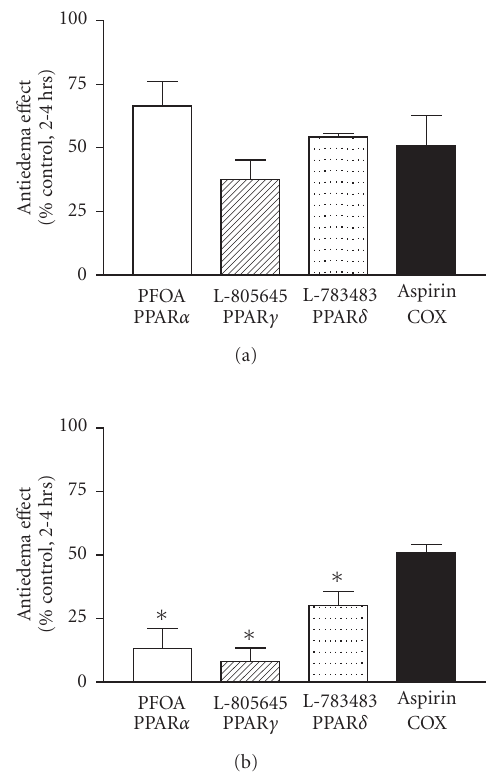
Figure 6: Percent inhibition of paw edema by various PPAR agonists and aspirin in wild-type (a) and hepatocyte-specific RXR α -deficient (b) mice. Data shown in Figures 2–5 above are expressed as the per- centage change in paw edema relative to control group 2–4h after carrageean injection. Values represent mean ± SEM. N = 3–6 mice per group. ∗ P < . 05 versus corresponding wild-type